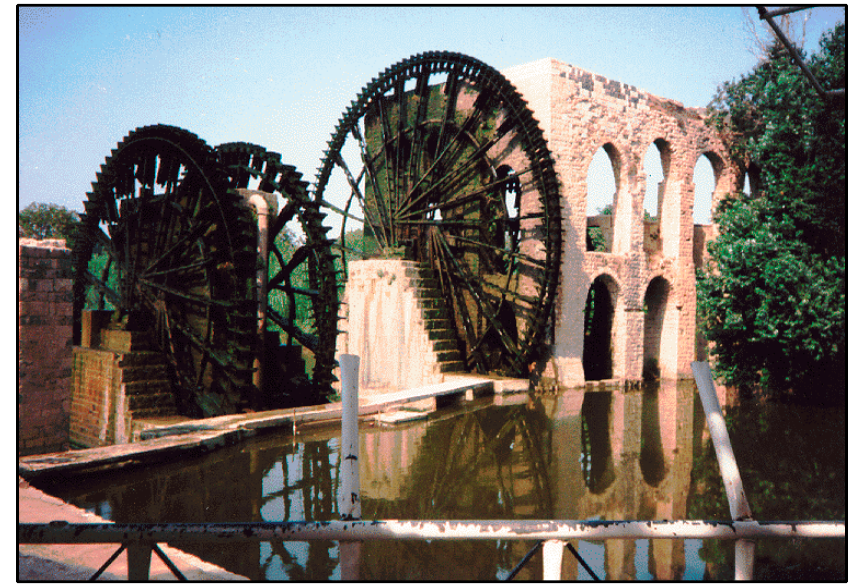
Figure 6. Noria in Hama, Syria [48].